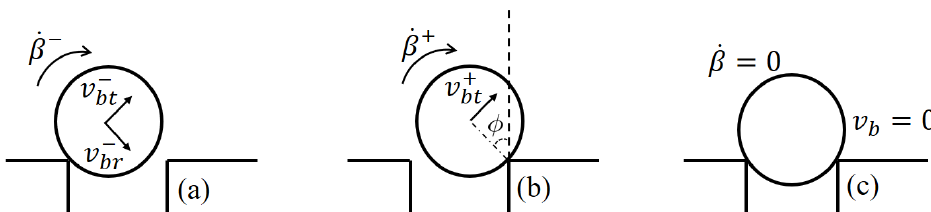
Figure 3. The motion of the iron ball ( a ) just before and ( b ) just after hitting the boundary of the hole, and ( c ) the iron ball at rest (this figure is redrawn from